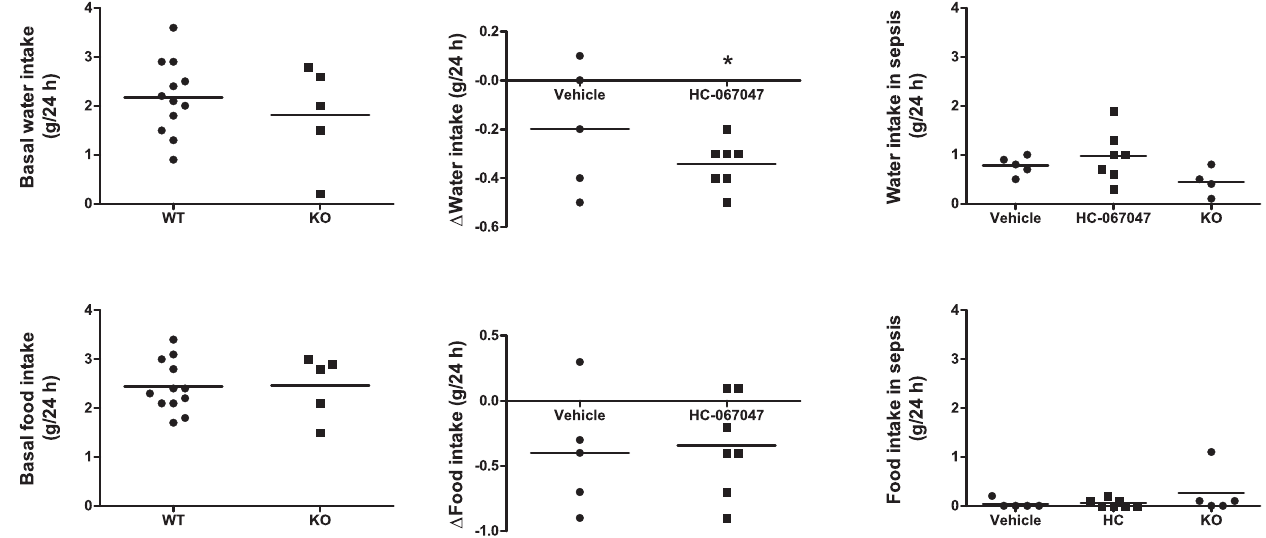
Figure 2. Water and food intake in TRPV4 WT and KO mice before and after induction of endotoxaemia. ( a ) Mean basal water intake in TRPV4 WT and KO mice over approximately 1 week (not including 7-day recovery period from telemetry surgery). ( b ) Change in water intake over 24-h period following i.p. administration of either vehicle (10% DMSO) or HC-067047. ( c ) Water intake over 24-h period following administration of LPS (12.5 mg/kg i.v.). ( d ) Mean basal food intake in TRPV4 WT and KO mice over approximately 1 week (not including 7-day recovery period from telemetry surgery). ( e ) Change in food intake over 24-h period following i.p. administration of either vehicle (10% DMSO) or HC-067047. ( f ) Food intake over 24-h period following administration of LPS (12.5 mg/kg i.v.). Data for individual animals are represented as individual symbols, with group mean denoted by horizontal line. *p<0.05, relative to vehicle-treated controls, 1-way ANOVA + Bonferroni post-hoc test, n =